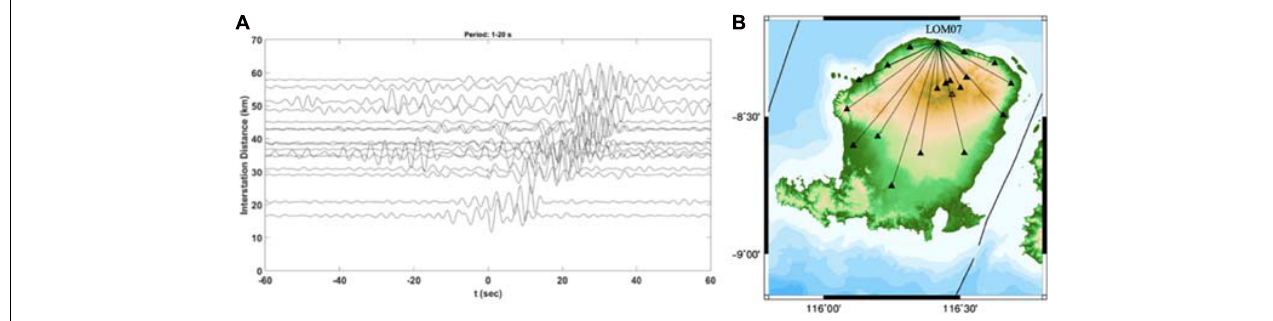
FIGURE 3 | (A) Examples of 1-month cross-correlations between station LOM07 with other stations. The cross-correlation result was filtered between 1 and 20 s. (B) The ray-path distribution between LOM07 with other stations.